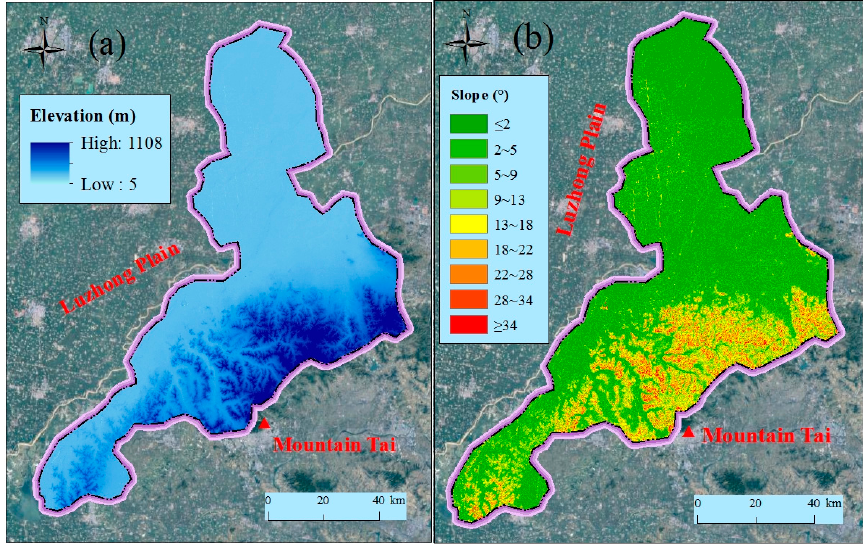
Figure 3. Spatial distribution of topographical elevation and slope in Jinan: ( a ) elevation; and ( b ) slope.